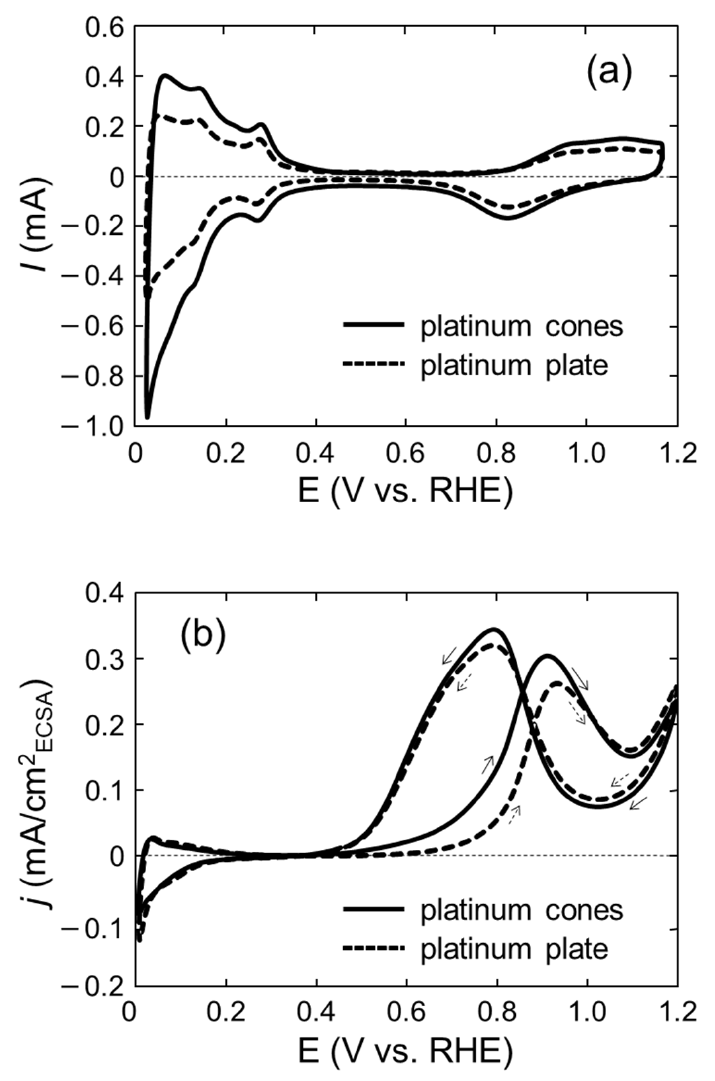
Figure 9. Cyclic voltammograms of the platinum cones and plate ( a ) in 0.5 mol/dm 3 H 2 SO 4 using a scan rate of 50 mV/s and ( b ) in 0.5 mol/dm 3 ethanol + 0.5 mol/dm 3 H 2 SO 4 using a scan rate of 20 mV/s.